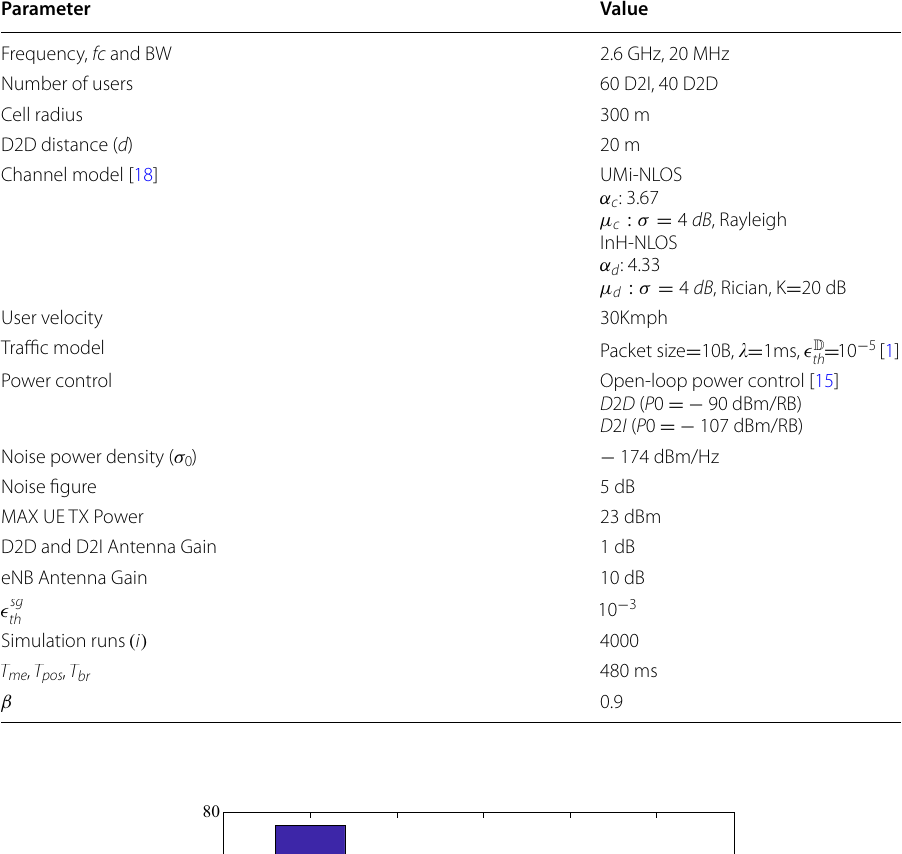
Table 3 Network parameters used in the simulator Parameter